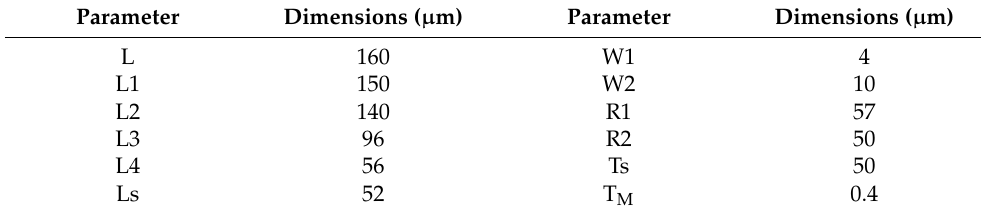
Figure 1. Proposed MTM unit cell: ( a ) front view; ( b ) side view. Table 1. Design parameters of proposed MTM unit